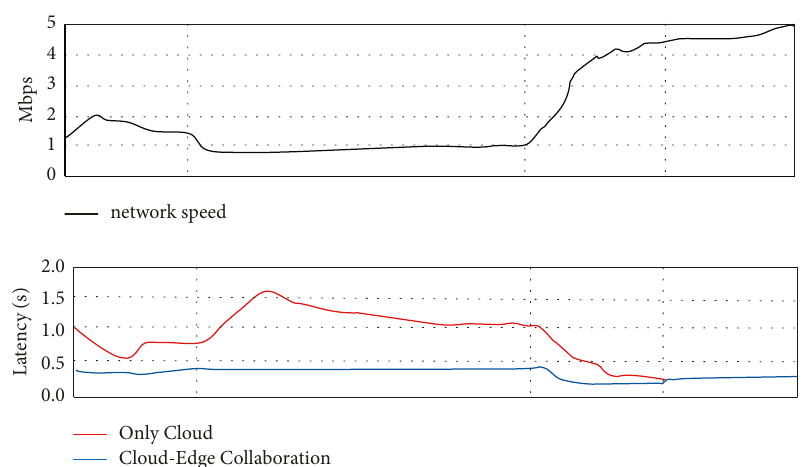
Figure 8: End-to-end latency analysis of AlexNet neural networks in different deployment